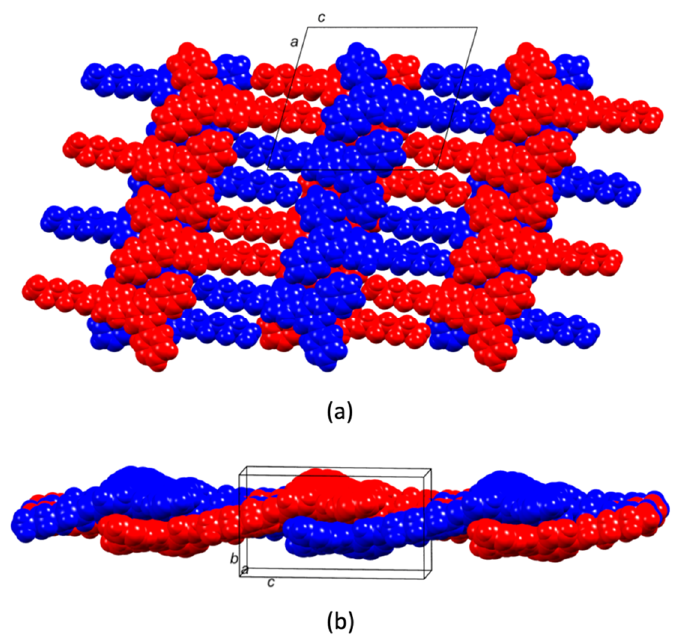
Figure 5. Part of two interwoven supramolecular sheets showing how the voids in one sheet (see Figure 4b) are occupied by n -hexyloxy chains from the next sheet. ( a ) Viewed down the b -axis, and ( b ) viewed approximately down the a -axis.